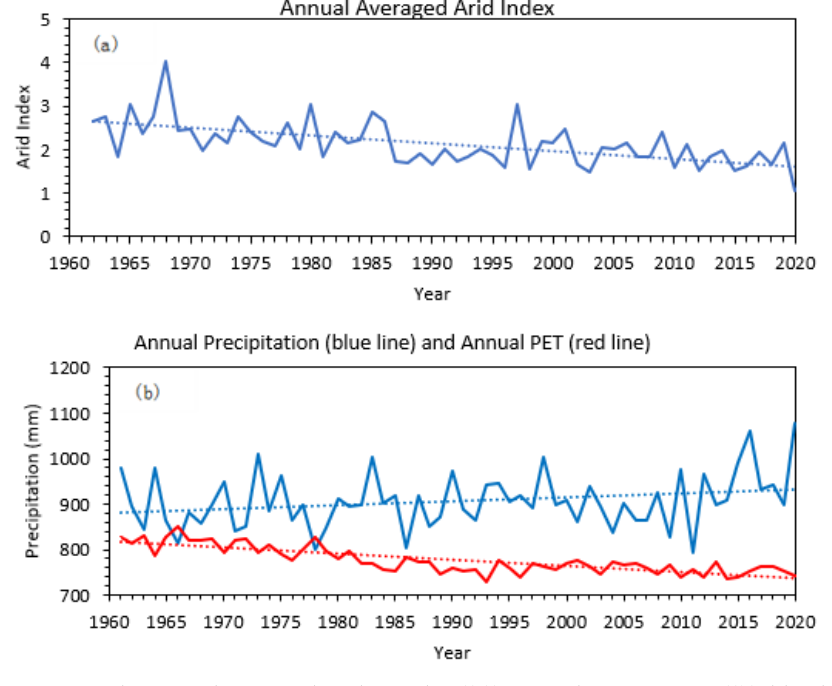
Figure 1. The annual averaged aridity index (( a )); annual precipitation (( b ), blue line); annual PET (( b ), red line) and their linear trend (( a , b ), dotted line) in China from 1961 to